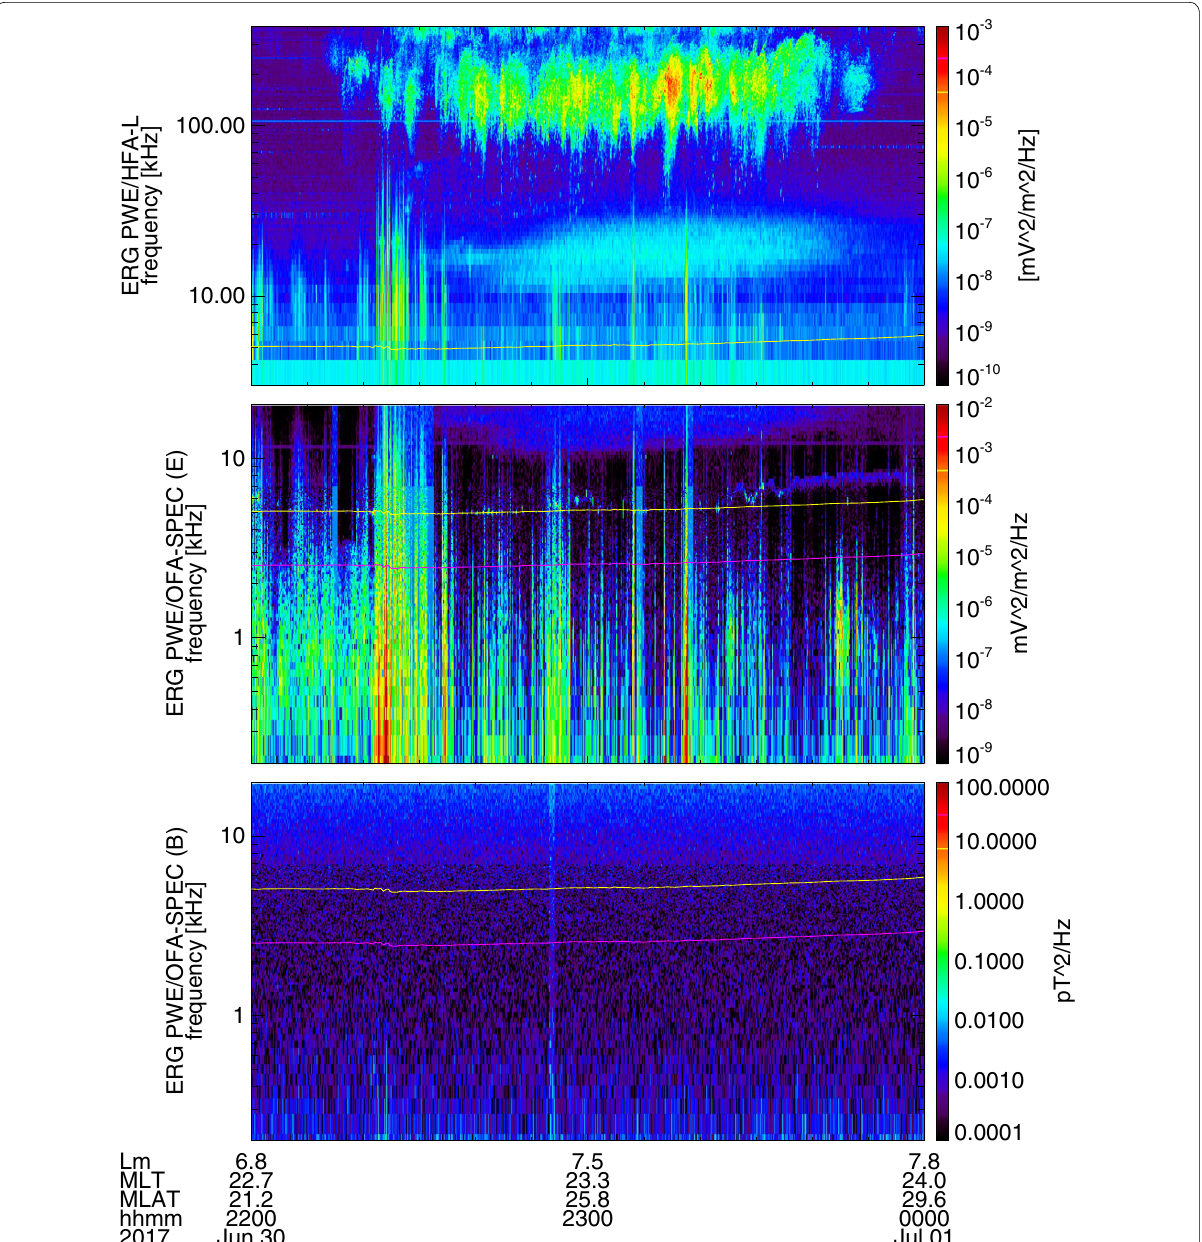
Fig. 4 Electromagnetic wave activity in the magnetosphere as observed by the Arase satellite for the 2-h time interval from 2200 to 2400 UT on June 30, 2017, when the footprint passed through the field of view of the all-sky cameras at Syowa